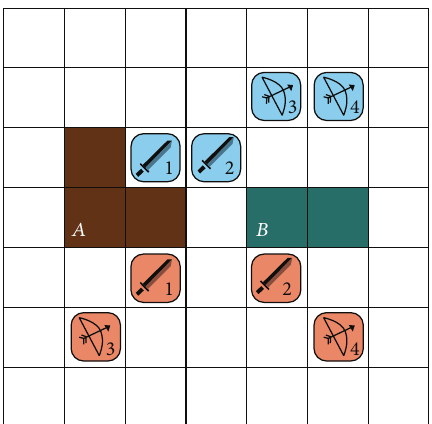
Figure 3: An example of TBW: Here are four red units and four blue units belonging to two players, respectively, on a square board. The units are divided into sword men and archers. The number written in the bottom right of each unit is the unit index. White tilts mean their terrain can be entered. However, ochre ones marked by “ 𝐴 ” illustrate hilly areas no unit can enter. The dark green tilts marked by letter “ 𝐵 ” illustrate lakes or rivers, which also cannot be entered, but archers can remotely attack the other side of the